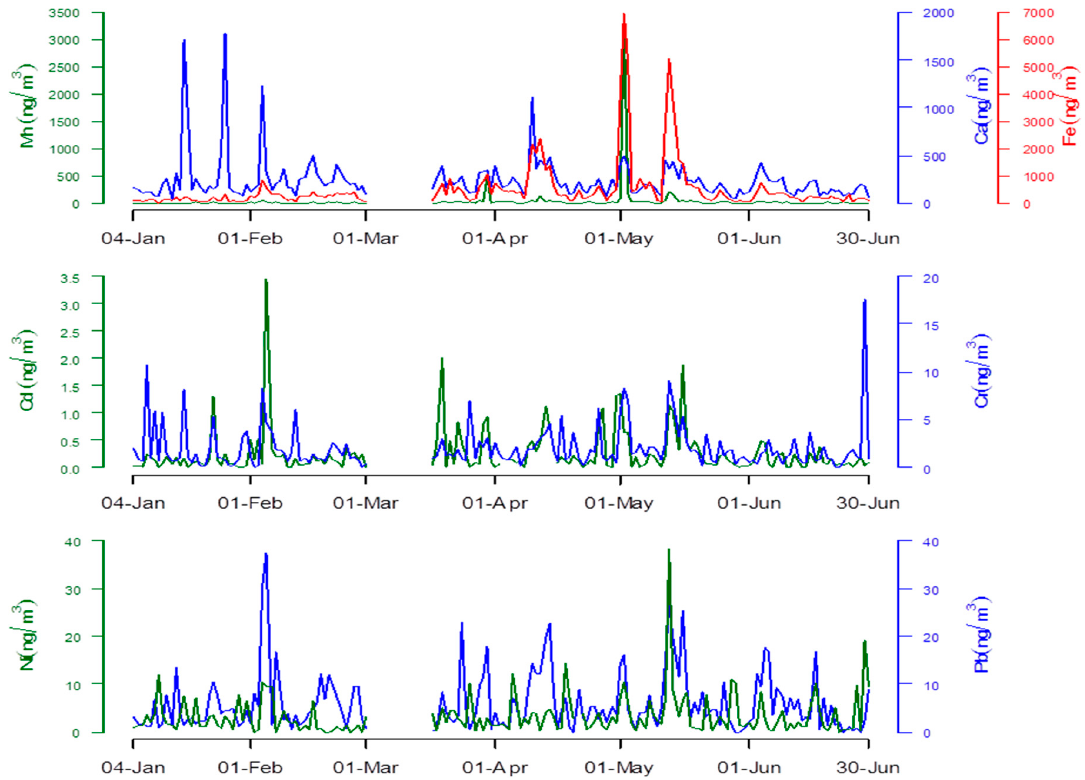
Figure 2. Daily concentrations of heavy metals between 4 January 2011 and 30 June 2011.